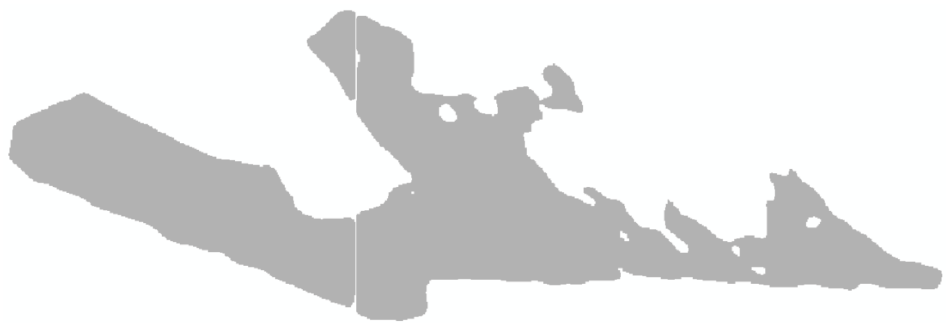
Figure 4. Automatic extraction